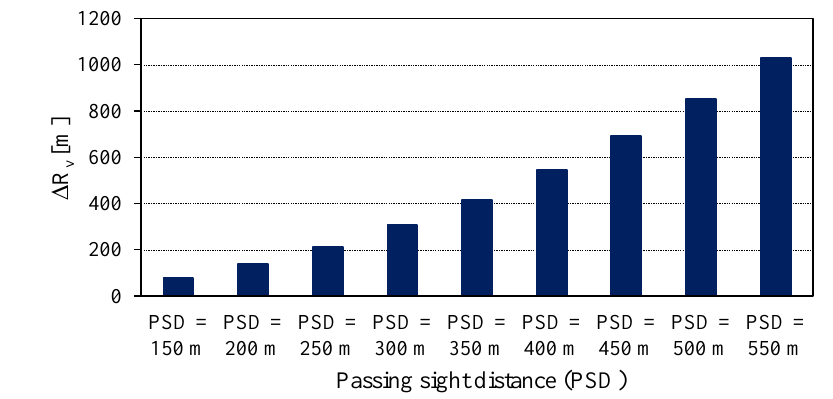
Figure 8. Δ R v between R v values calculated for h 2(15) = 1.39 m and h 2(m) = 1.48 m.